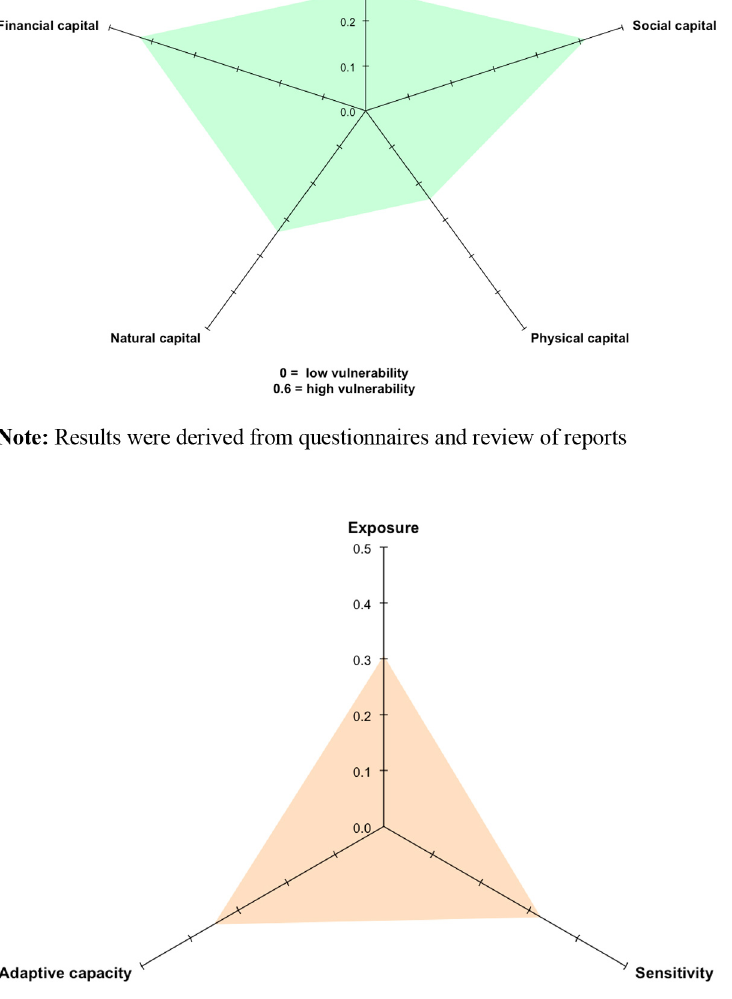
Figure 5. Vulnerability of the main components of the LVI-IPCC at the study